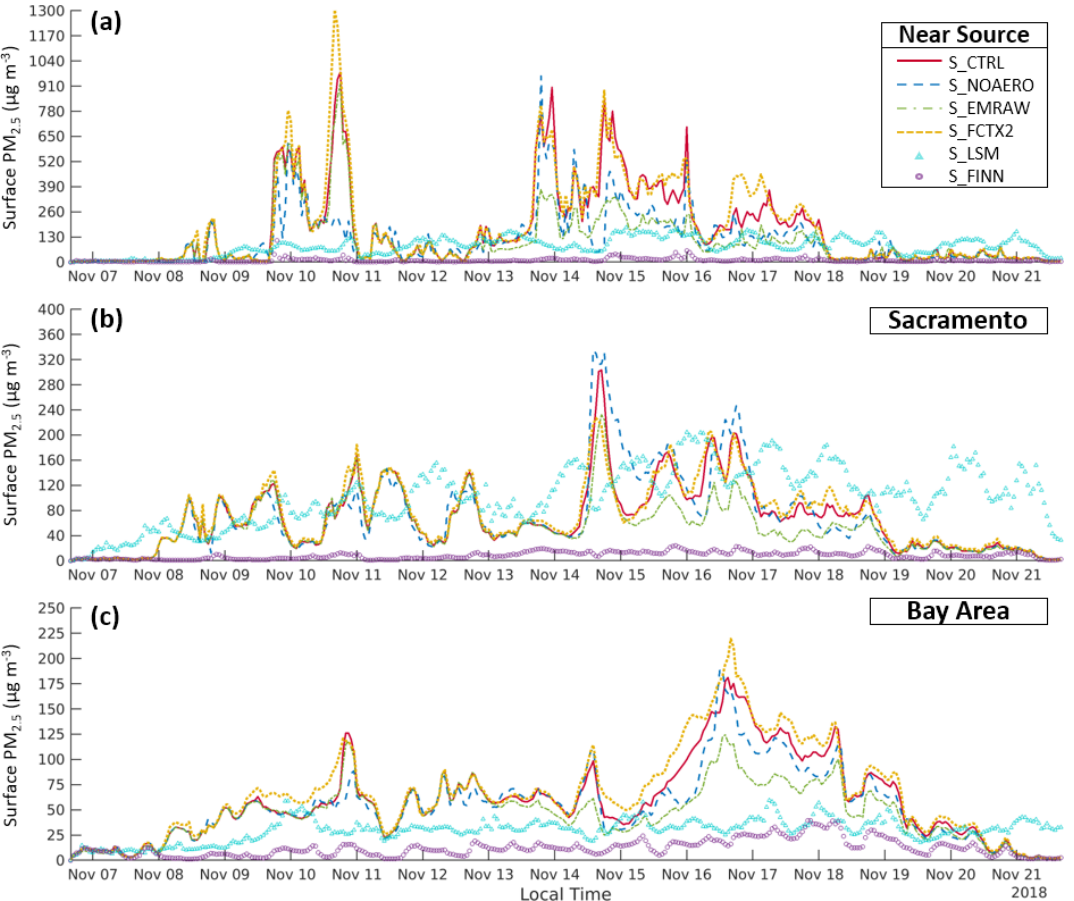
Figure 13. Time series of surface PM 2 . 5 (µgm − 3 ) predicted by the sensitivity simulations (Table 1) averaged for the three areas of study: (a) near the wildfire ( N = 5), (b) Sacramento ( N = 7), and (c) the Bay Area ( N = 13). S_ENTR is omitted from the figure as it resulted in less than 1% change from S_CTRL. In the Bay Area, S_FCTX2 generally predicted more surface PM 2 . 5 , recovering 10–35µgm − 3 on 14–16 November when S_CTRL significantly underpredicted PM 2 . 5 compared to observations. S_EMRAW demonstrates the impact of increasing the emissions inventory for 13–16 November. In the Bay Area, using the unperturbed emissions inventory reduces PM 2 . 5 by more than 30% over 14–16 November. The impact of the aerosol feedback mechanism on PM 2 . 5 (S_NOAERO) is location dependent. Excluding the feedback to meteorology generally reduces PM 2 . 5 near the wildfire and in the Bay Area, while increasing PM 2 . 5 in Sacramento. Employing the ACM2 PBL scheme results in a vastly different temporal evolution with a distinct diurnal pattern (S_LSM). FINN input fire data produce very little PM 2 . 5